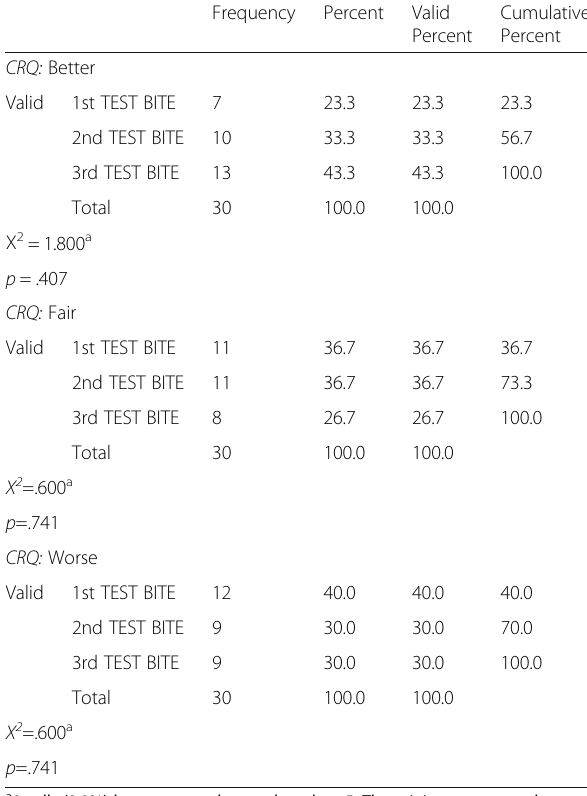
Table 3 Descriptive statistic showing the association between the number of test bite record and the categories of record quality. CRQ: Category of Record Quality